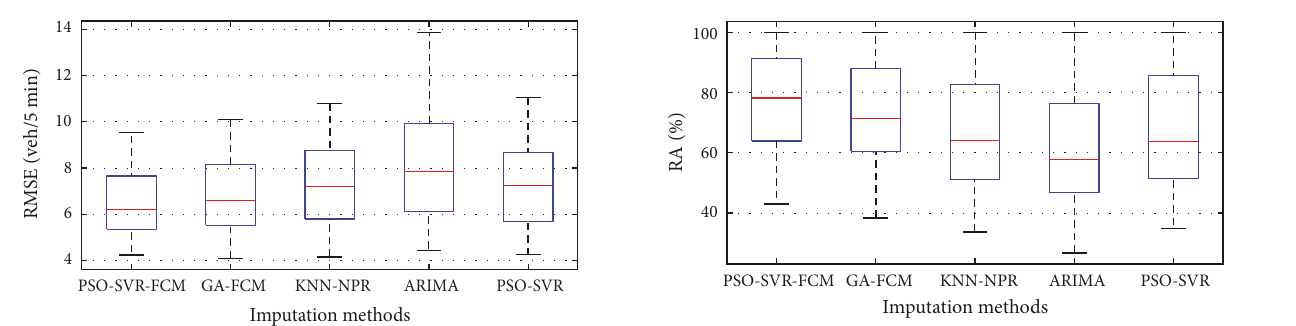
Figure 18: The box-whisker plots for RMSEs of different imputation methods.